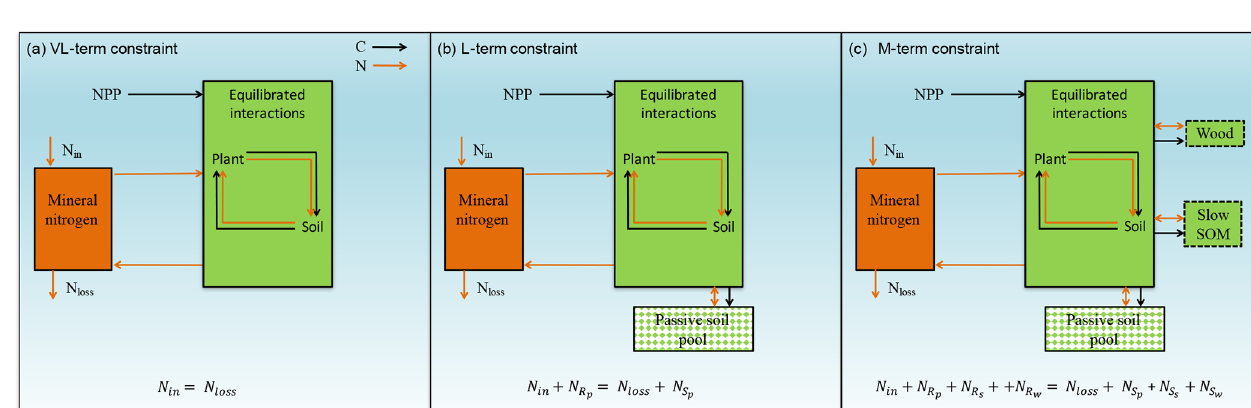
Figure 3. Graphic and mathematical illustrations of the (a) very-long-term (VL), (b) long-term (L), and (c) medium-term (M) nutrient recycling constraints. The VL constraint considers all plant–soil processes to be in equilibrium, the L constraint considers all but passive SOM to be in equilibrium, and the M constraint considers all but the woody biomass, slow, and passive SOM pools to be in